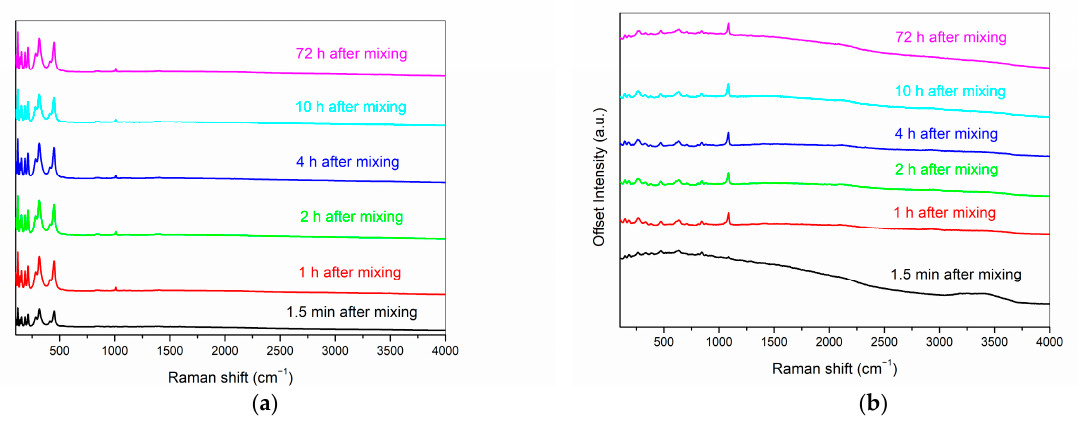
Figure 9. Raman spectra of the smeared ProRoot MTA ( a ) and RS+ ( b ) samples at selected time intervals following mixing. Individual spectra have been vertically o ff set for clarity.